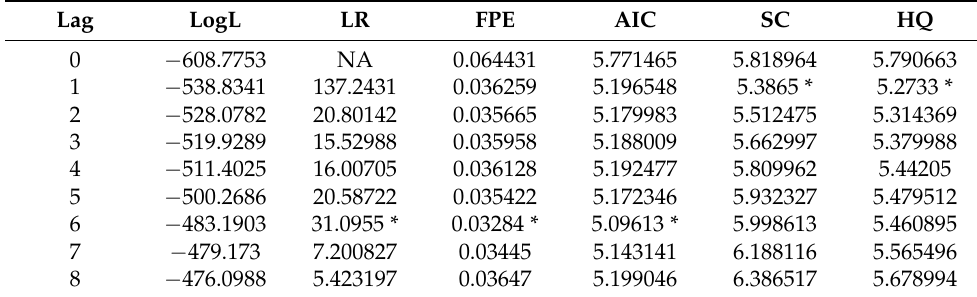
Table 7. Lag length criteria: GPR Israel, FXFXD, and FSI.